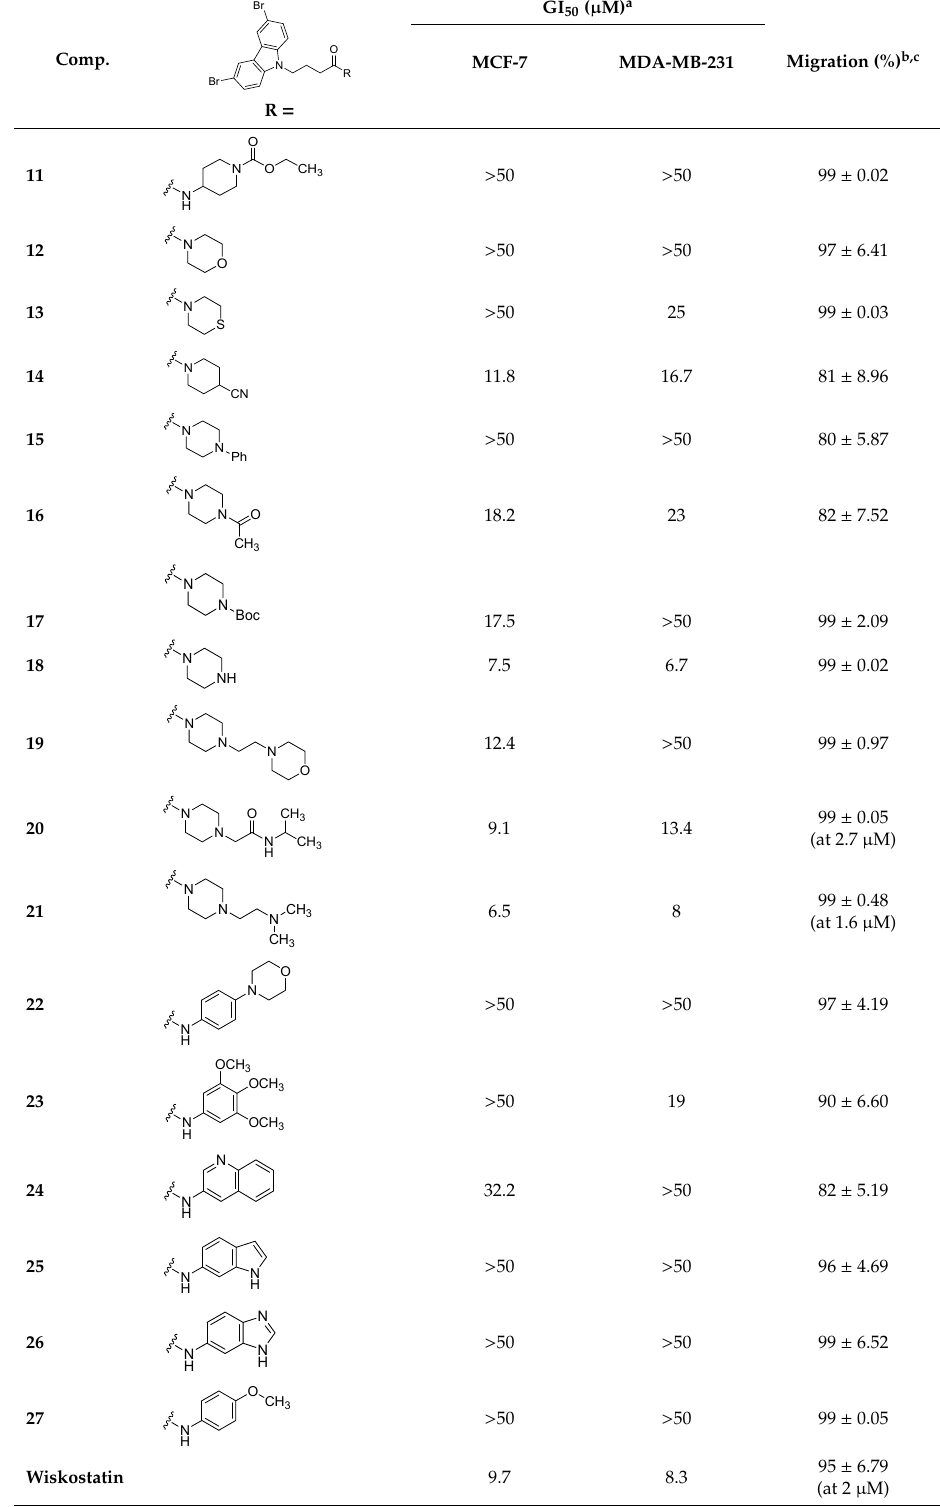
Table 1. Cell growth inhibition and anti-migration activity of 3,6-dibromocarbazole derivatives.